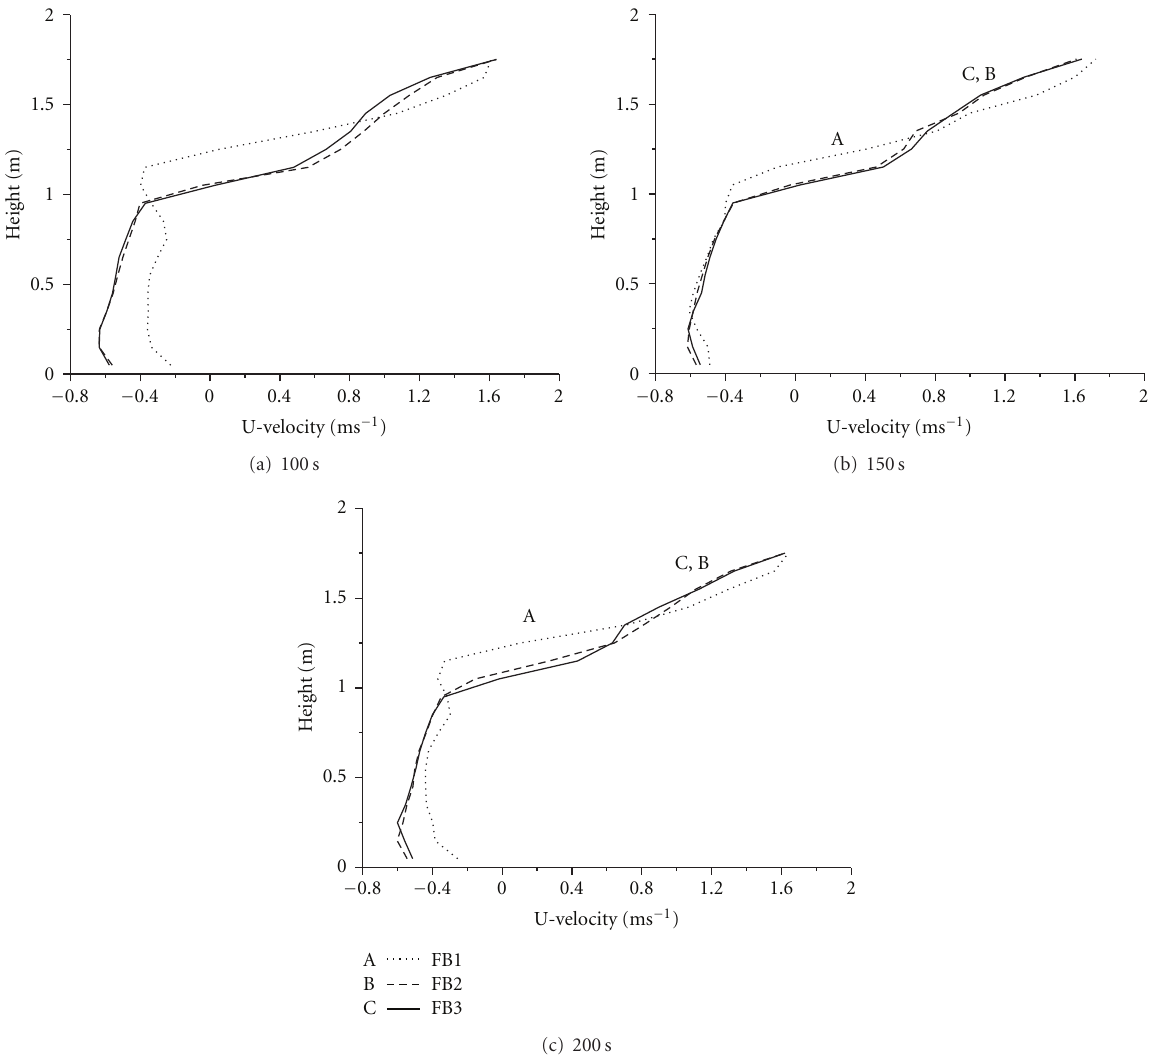
Figure 10: Horizontal velocity components at